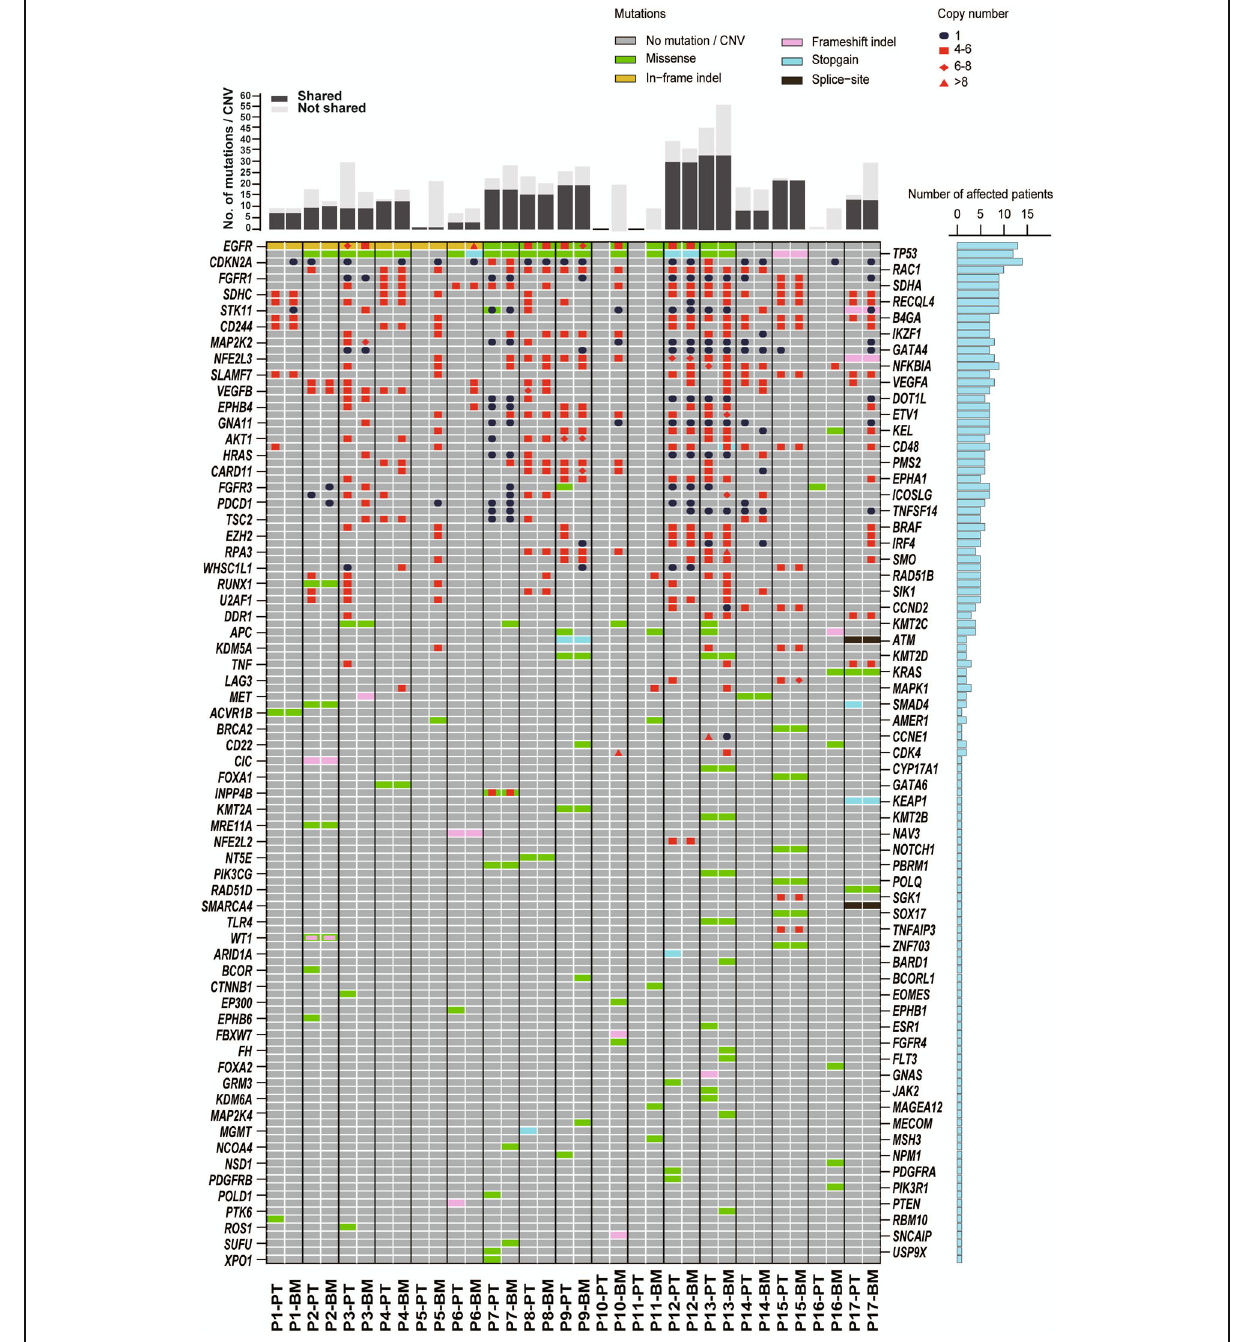
Fig. 4 Genetic fingerprints of somatic variants in matching primary and secondary tumors. The different types of SNVs/indels and CNVs and associated copy number (CN) changes identified by capSMART analysis of patient tumors are indicated by color coding. PT = primary tumor; BM = bone metastasis. Shared SNVs/indels were scored when both PT and BM had a variant allelic frequency of ≥ 3%, shared gene amplifications were scored when both PT and BM had a CN ≥ 4 and shared gene deletions were scored when both PT and BM had a CN ≤